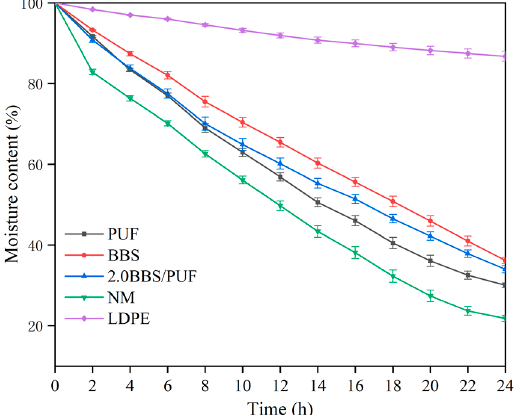
Figure 8. Water retention of different mulching films. Error bars represent standard deviations from five replicates.